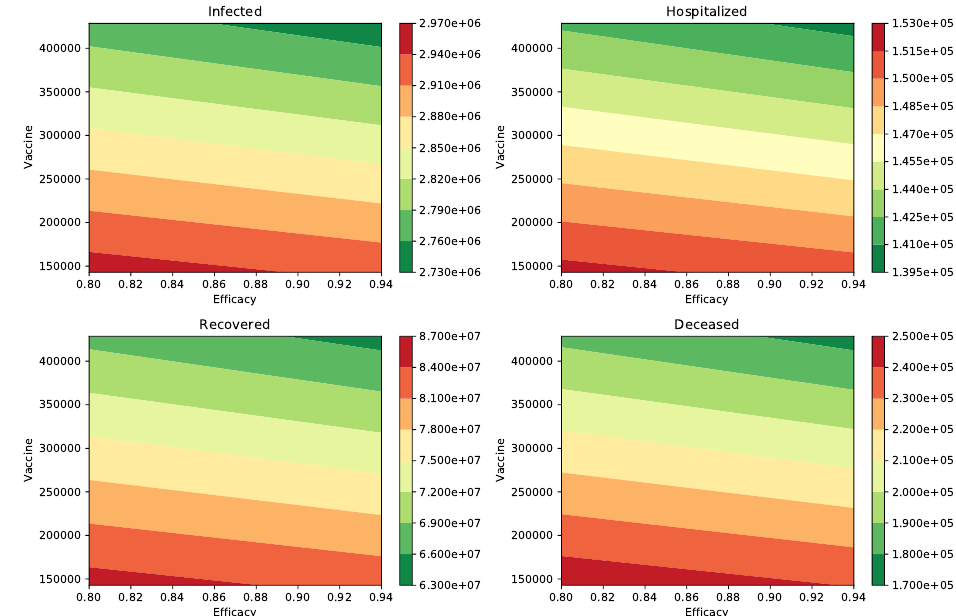
Figure 3. Impact of the inoculation rate and efficacy of the vaccine on the peak of the infected (I) and hospitalized (H) subpopulations. In addition, on the deaths (D) and recovered (R) cases. In these scenarios, the infectiousness of the asymptomatic individuals relative to symptomatic is 75% ( β A = β I ), and the percentage of infections that are asymptomatic is 50%. In all these scenarios the transmission rate is β = 0.2.